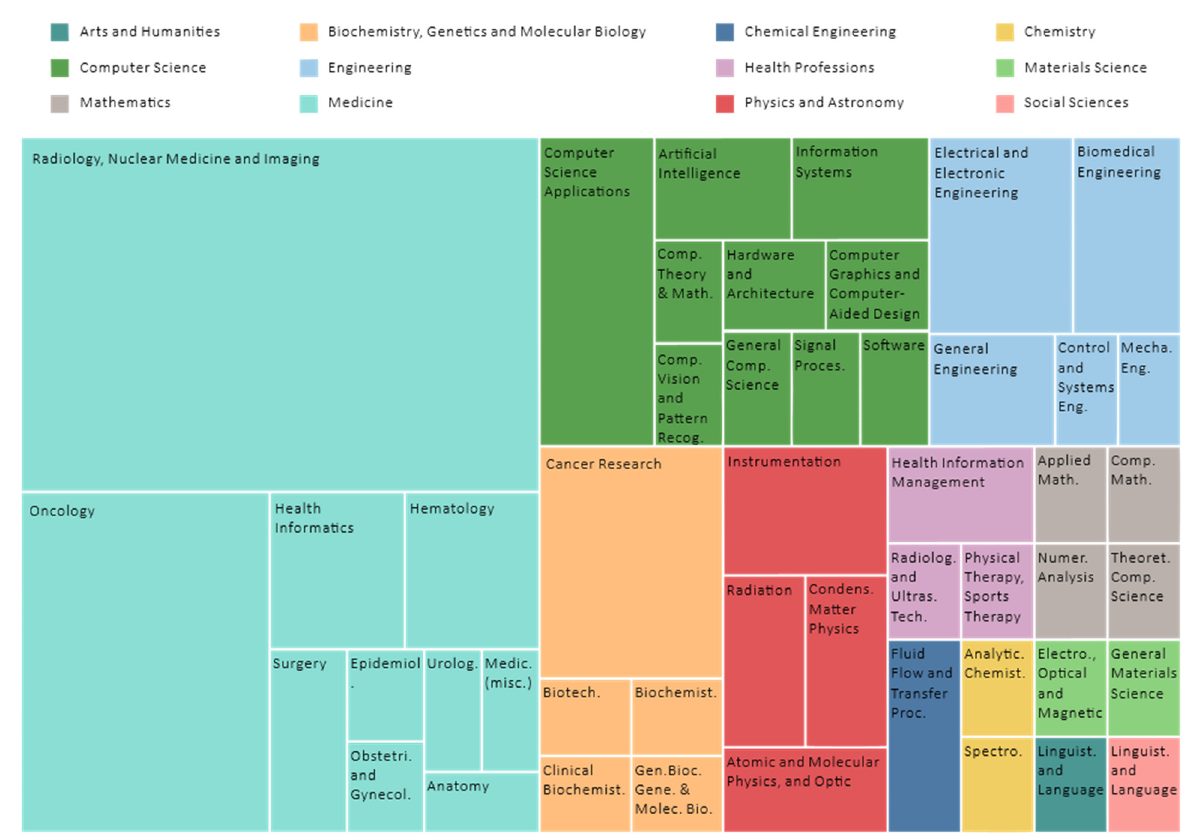
Figure 14. Subject area profiling.